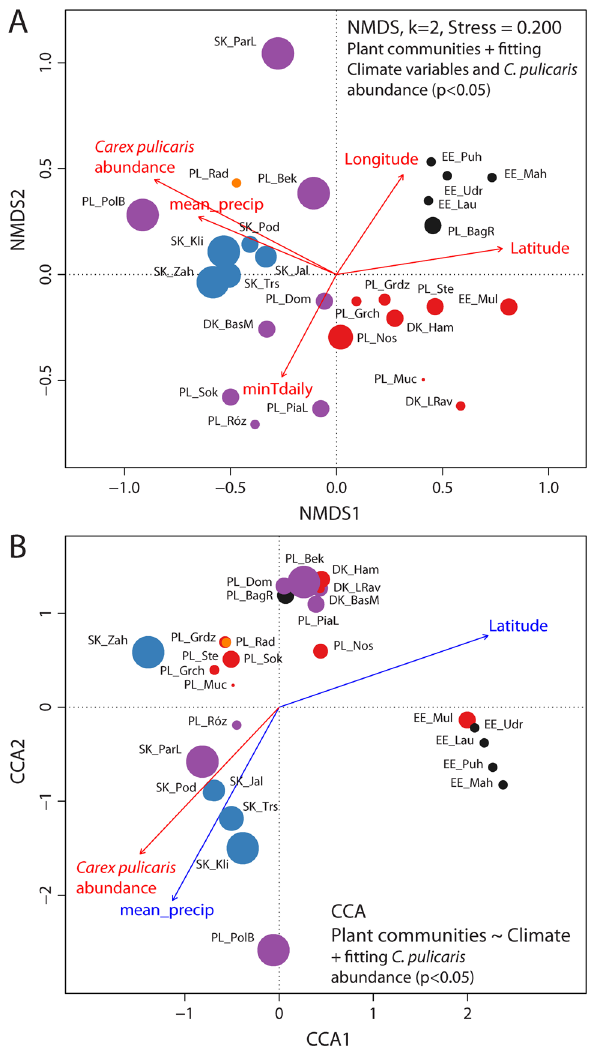
explained along NMDS1 and NMDS2. Climate variables significant at p < 0.05 fitted to ordination biplot; ( B ) canonical correspondence analysis (CCA) performed on matrices of species composition data and Climate variables. Only significant variables (p < 0.05) explaining constrained variation, identified based on forward selection, were used in parsimonic CCA. Locality abbreviations follow Table 1. Colouring corresponds to clustering pattern, symbol size reflects Carex pulicaris abundance. Carex pulicaris abundance vector is fitted to NMDS and CCA models (p < 0.05). Colouring of symbols: black—Estonian group, blue—Slovakian group, orange—Radecz group, purple—Ambiguous group, red—Polish